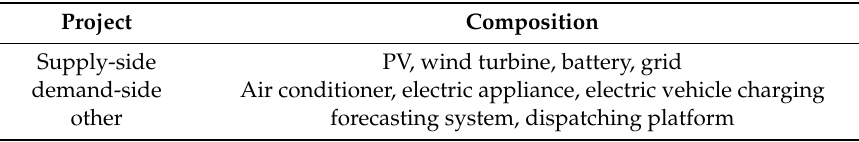
Table 1. The composition of the building renewable energy system.